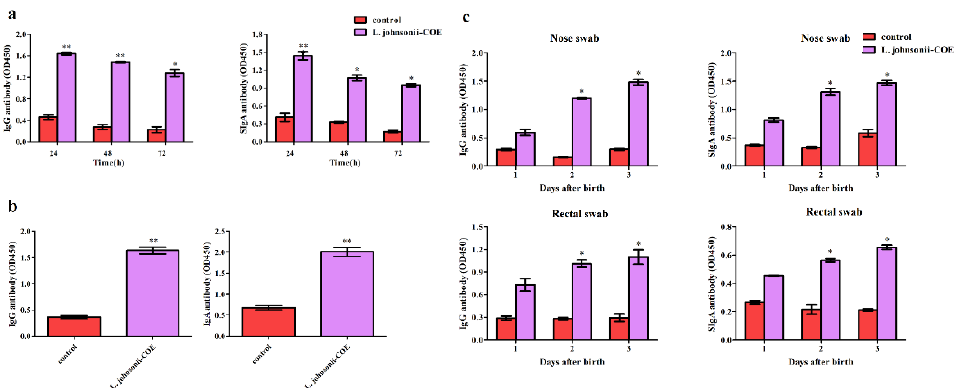
Figure 8. Levels of the antibodies in colostrum and piglets. ( a ) Colostrum anti-PEDV SIgA and IgG antibody levels of the sow groups immunized with L. johnsonii-COE ; ( b ) serum anti-PEDV SIgA and IgG antibody levels of the 4-day-old piglets; ( c ) nasal mucosa and rectal mucosa anti-PEDV SIgA and IgG antibody levels of the piglets at 1 day, 2 day, and 3 days of age. * ( p < 0.05) and ** ( p < 0.01).